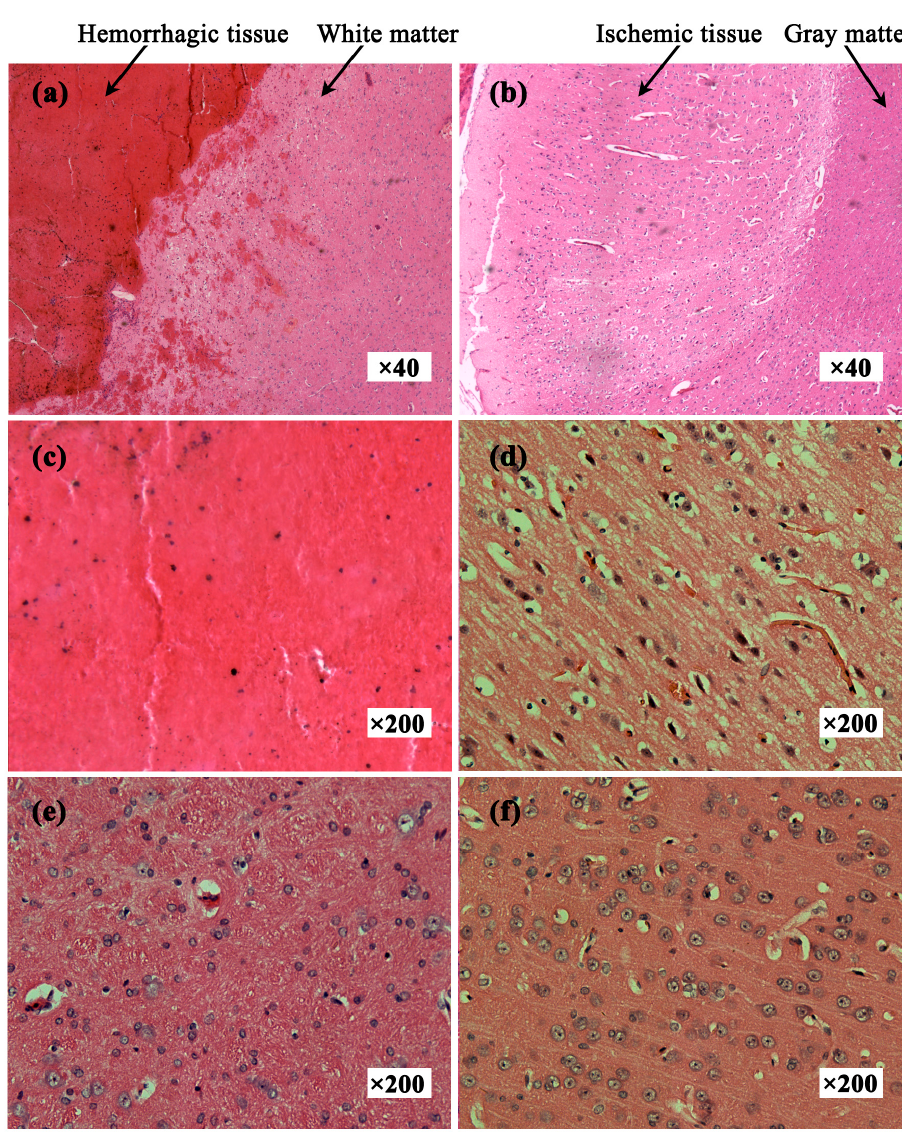
Figure 7. Hematoxylin and eosin-stained tissue sections. ( a ) Hemorrhagic tissue with surrounding white matter; ( b ) Ischemic tissue with surrounding gray matter; ( c ) Hemorrhagic tissue (blood clot); ( d ) Ischemic tissue; ( e ) Normal white matter; ( f ) Normal gray matter.